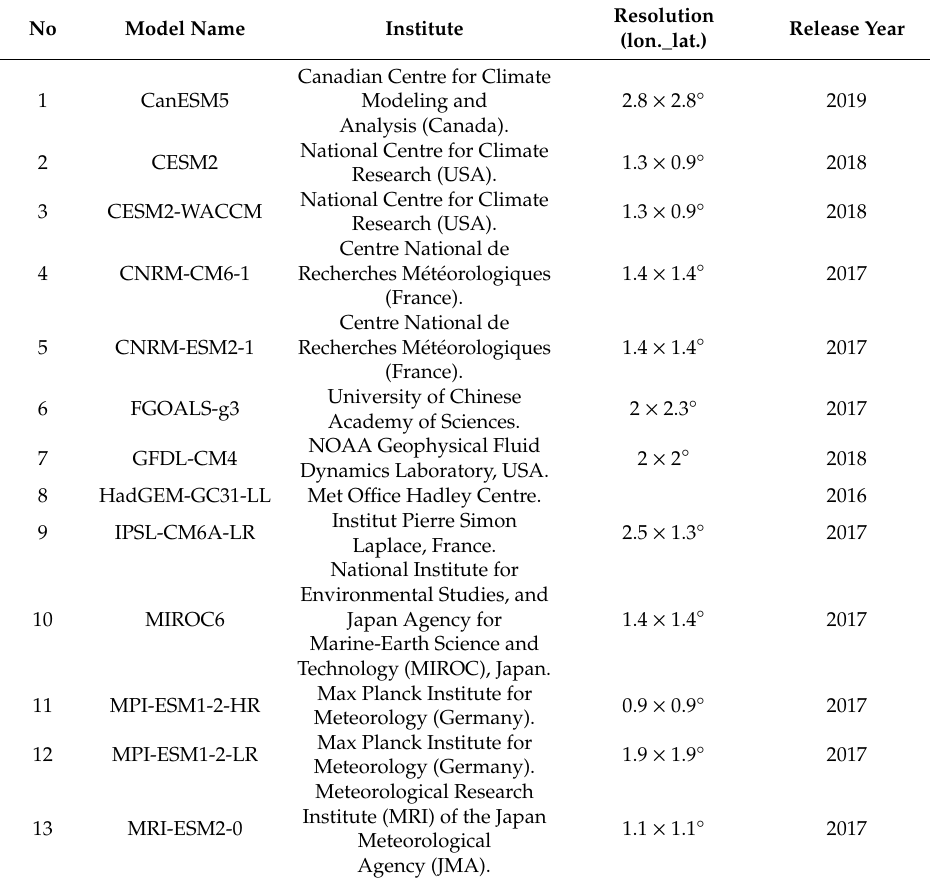
Table 1. Description of CMIP6 models used in the study showing their origin, resolution, and release year. All models acquired r1i1p1 global attribute indices for this